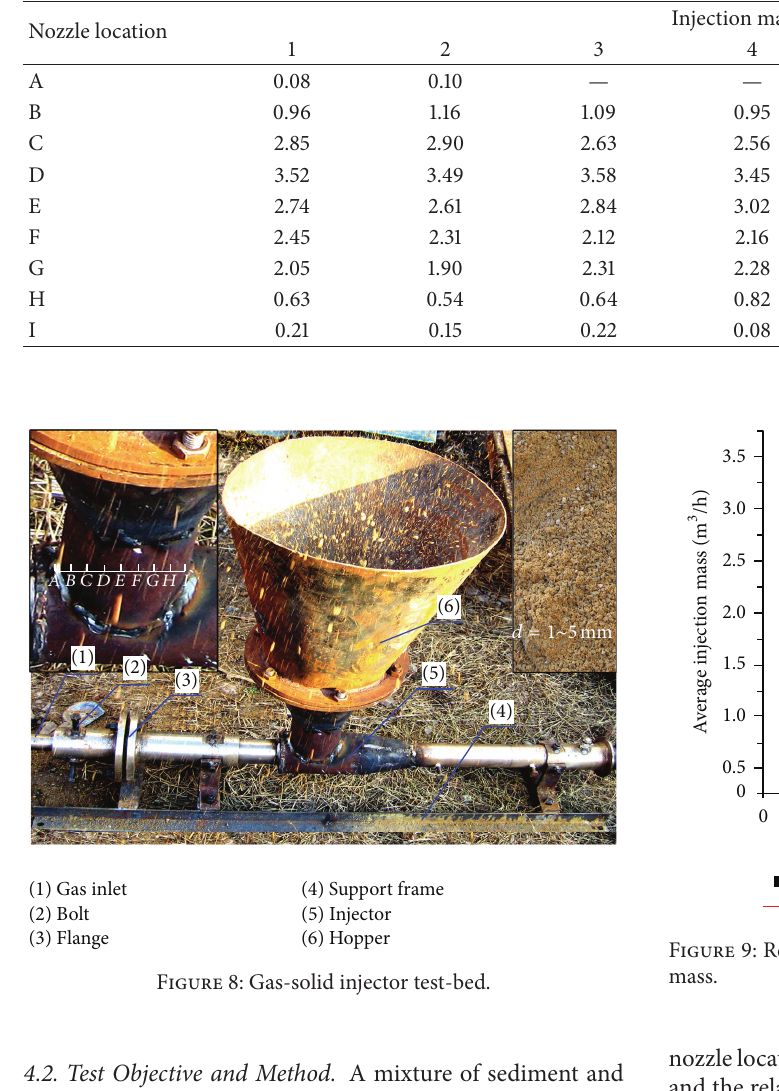
Table 2: Injection mass of gas-solid injector test-bed.